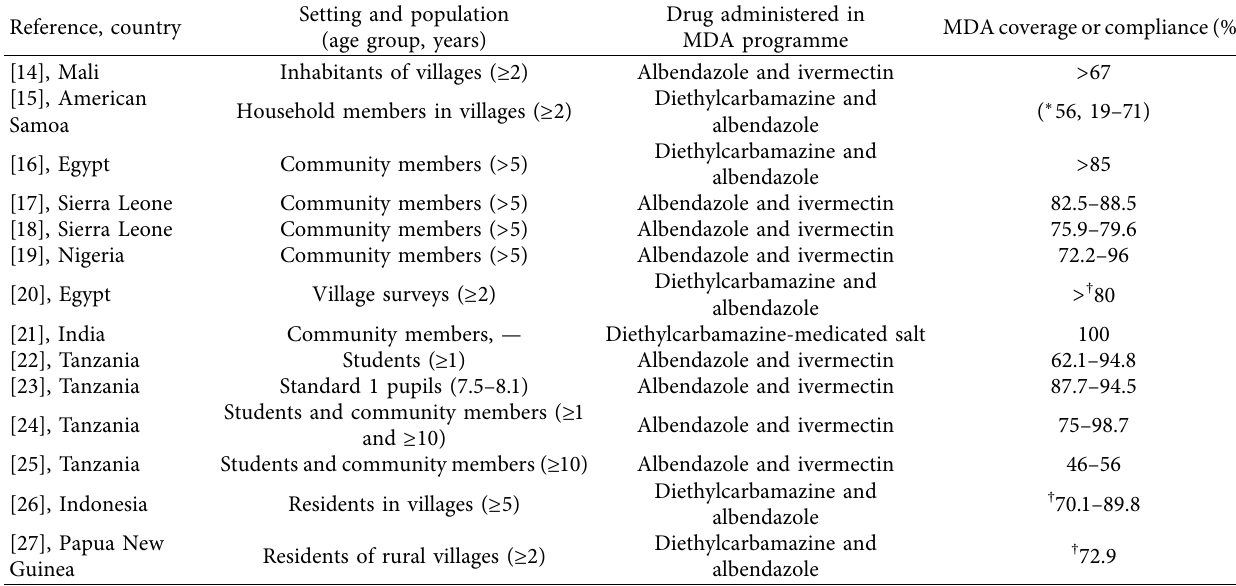
Table 1: Mass drug administration coverage and compliance in lymphatic flariasis studies included in this